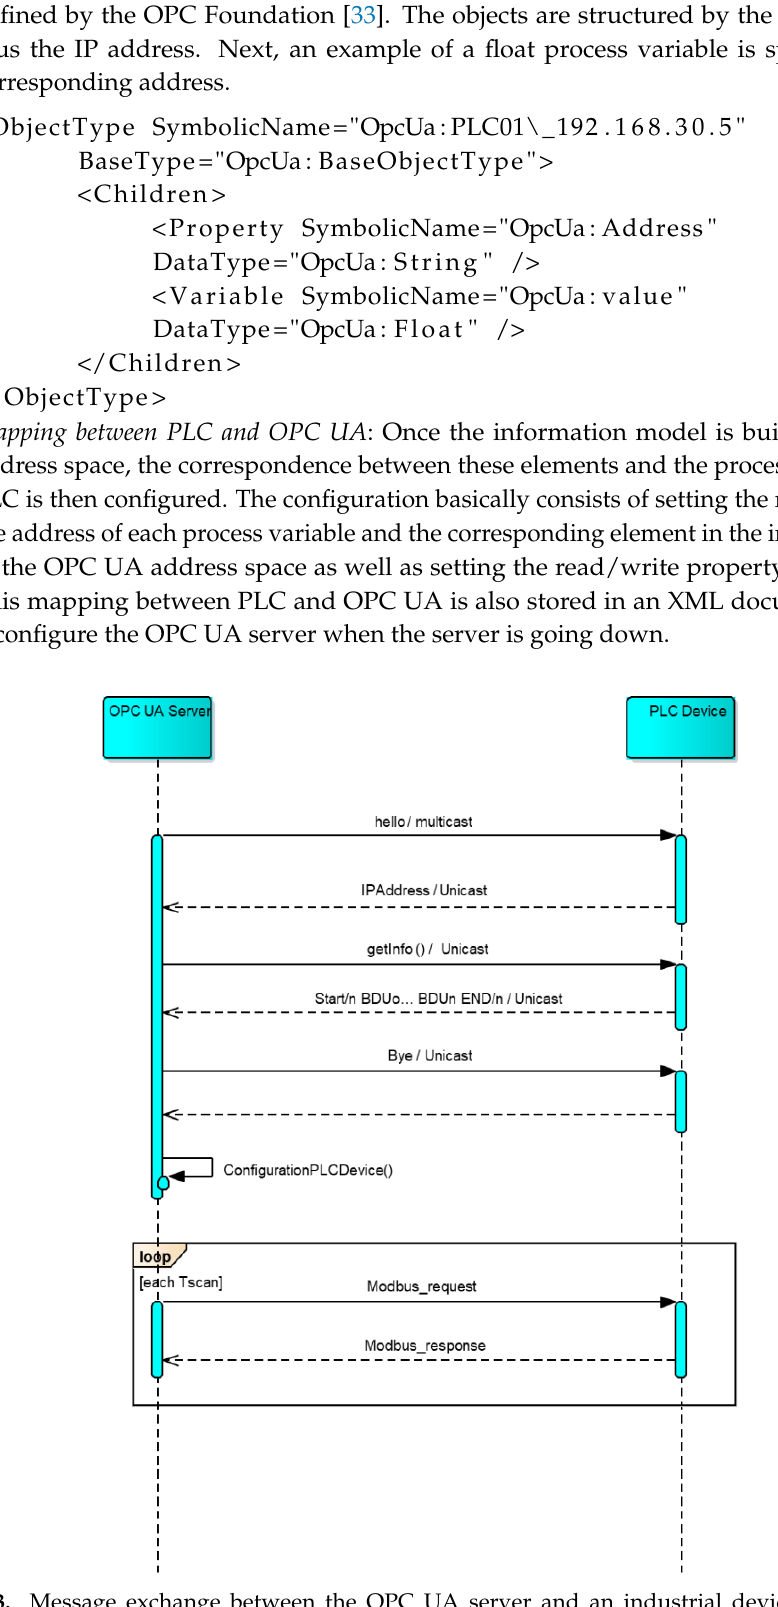
Figure 3. Message exchange between the OPC UA server and an industrial device during the auto-configuration of OPC UA server in TCP/IP mode and the subsequent periodic requests/responses in Modbus